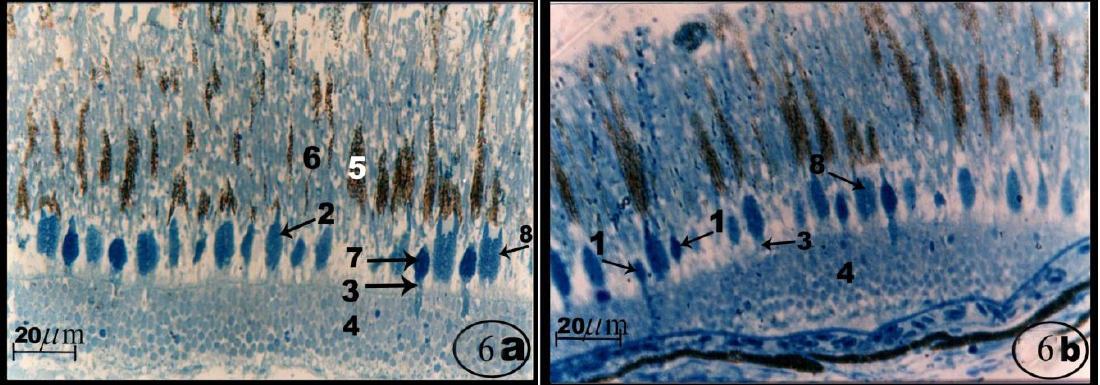
Nuclear Layer ; 5: Outer Plexiform Layer; 6: Pigment Epithelium ; 7: Rods; 8: Short Single Cone; 9: Twin